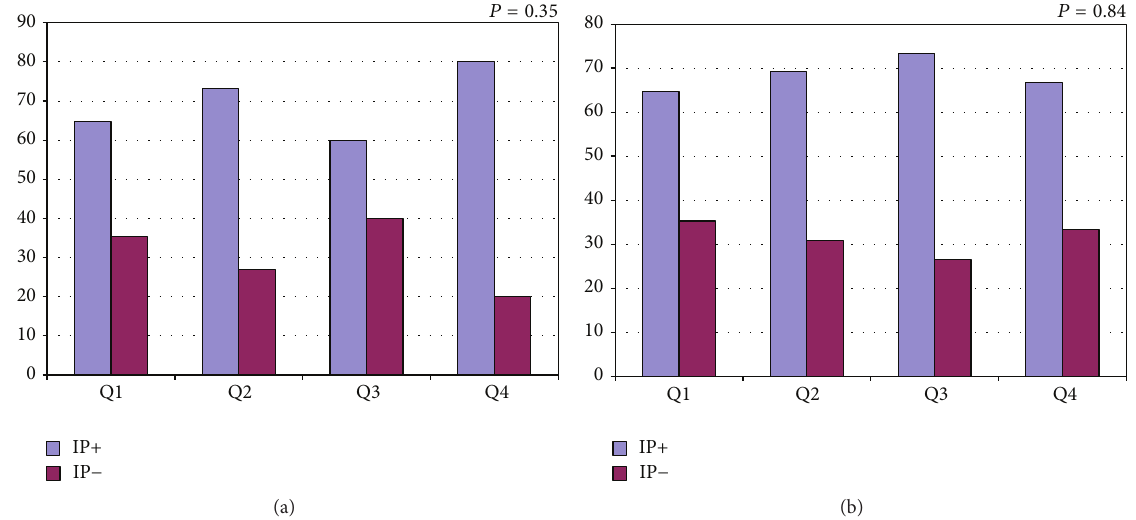
Figure 2: Graphs showing the percentage of patients who demonstrated ischemic preconditioning (IP+ in blue) and who did not demonstrate ischemic preconditioning (IP − in red) stratified into quartiles of A1c (a) and Fasting Glycemia (b). IP=ischemic preconditioning; Q= quartile (s). 𝑥 -axis represents the percentage of patients, and 𝑦 -axis represents the quartiles of A1c and Fasting Glycemia. Extracted from